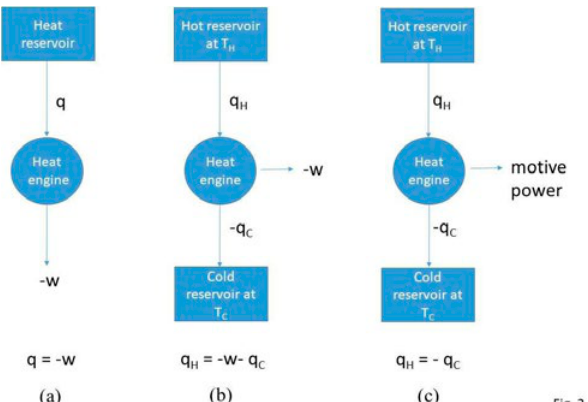
Figure 4. ( a) a heat engine with a single heat source; (b) a heat engine operating between two reservoirs at T H and T C tempera- tures; (c) the steam engine according to the caloric theory of heat. In the three schemes q is the heat expended, -q the heat absorbed by the reservoir and -w the work done by the